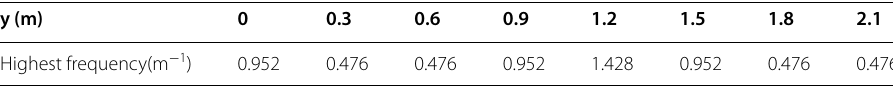
Table 4 Highest frequency of shape #2